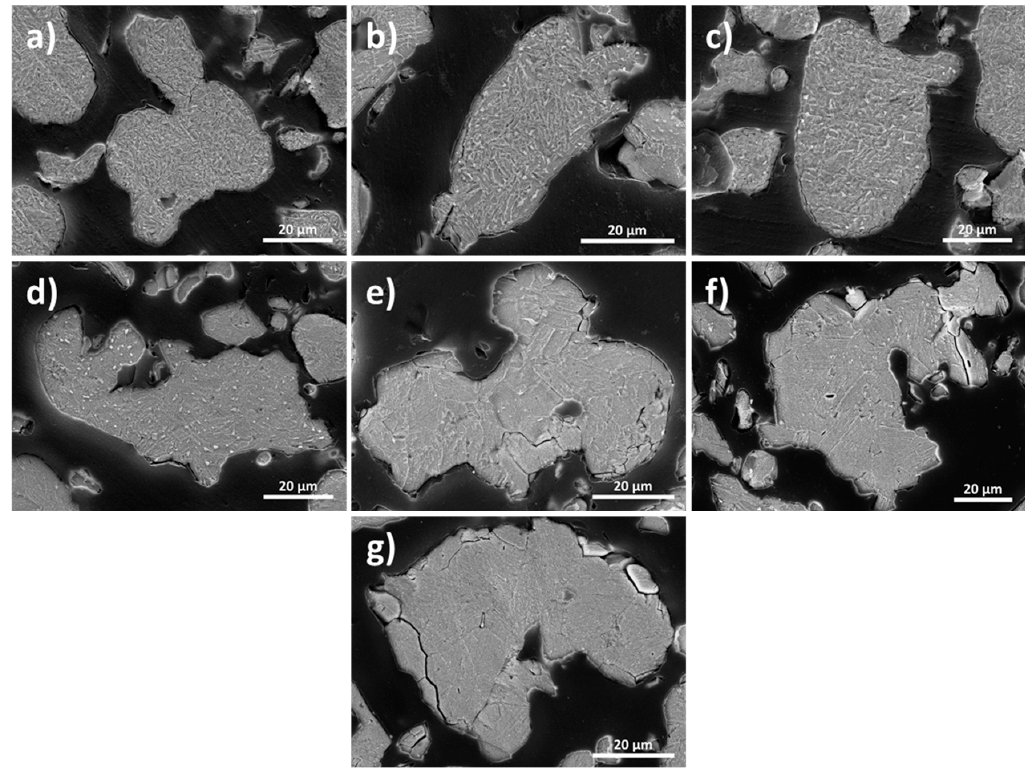
Figure 1. SEM cross-sectional microstructure of the ( a ) water atomized (WA) powder, heat treated at ( b ) 673 K, ( c ) 723 K, ( d ) 743 K, ( e ) 773 K, ( f ) 803 K, and ( g ) 823 K.